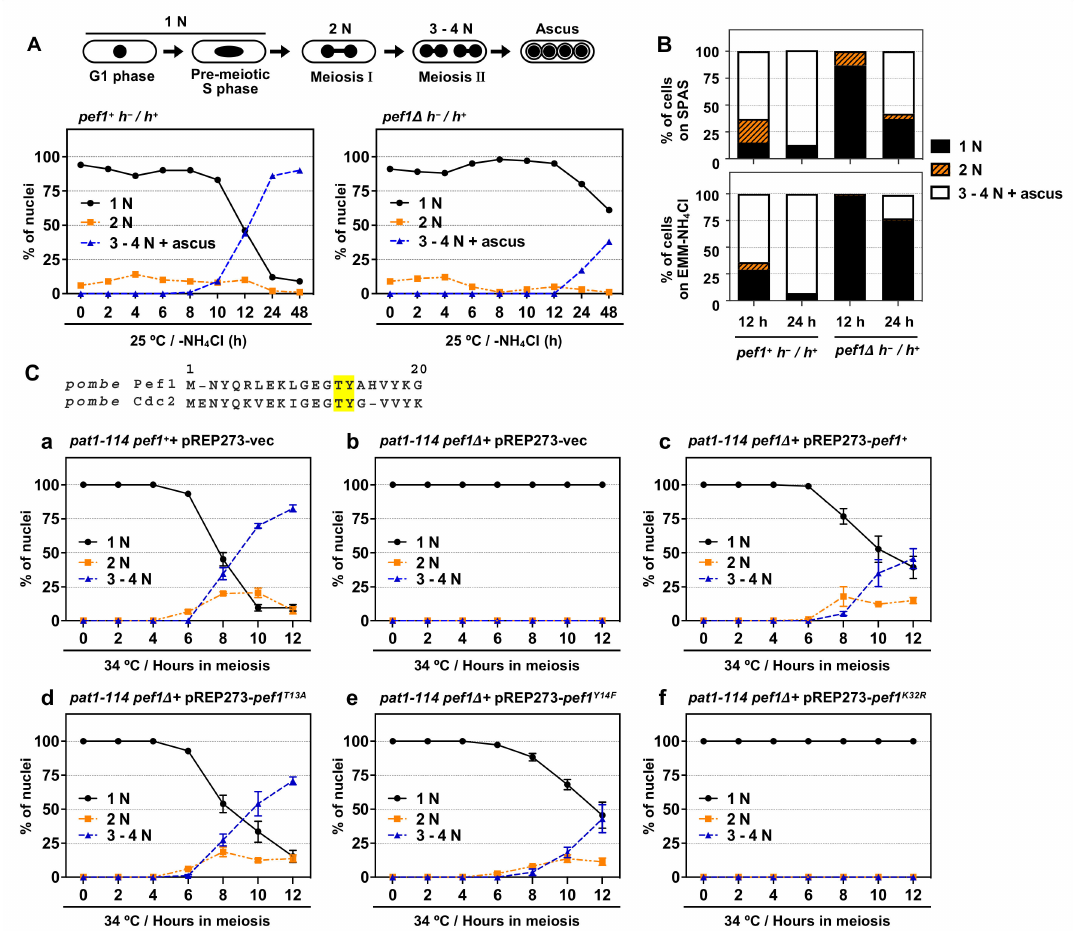
Figure 1. pef1 is required for meiotic progression. ( A , B ) Illustration representing alterations in the number of nuclei during meiosis in S. pombe . Diploid wt (AN0353) and pef1 ∆ (MS100) cells were cultured in YES at 33 ◦ C and then the cells were transferred to EMM–NH 4 Cl liquid medium or spotted on SPAS or EMM–NH 4 Cl agar medium. After incubating the cells for the indicated times at 25 ◦ C, they were fixed, stained with DAPI and observed using fluorescence microscopy. The graph indicates the percentages of G1-pre-meiotic S phase (1N, black solid line), meiosis I (2N, orange broken line) and meiosis II and ascus (3–4N, blue broken line). At least 100 cells were counted at each time. ( C ) Illustration representing N-terminal amino acid alignment of Pef1 with Cdc2. pat1-114 pef1 + (FY7122) or pat1-114 pef1 ∆ (MS254) haploid cells were transformed with pREP273-empty vector (Ca, Cb), pREP273- pef1 + (Cc), pREP273- pef1 T13A (Cd), pREP273- pef1 Y14F (Ce) or pREP273- pef1 K32R (Cf). Exponentially grown cells were incubated in EMM–NH 4 Cl for 14–16 h at 25 ◦ C. Synchronous meiosis was induced by shifting the cultures from a permissive temperature (25 ◦ C) to a restrictive temperature (34 ◦ C). Then, the cells were fixed at the indicated times, stained with DAPI and observed using fluorescence microscopy. The graph indicates the percentages of cells in the G1-pre-meiotic S phase (1N), meiosis I (2N) or meiosis II (3–4N). At least 100 cells were counted each time. Results are expressed as means ± SEM from three independent